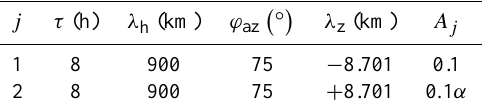
Table 1a. Properties of the AGWs to be superposed to generate the perturbation velocities. Note: The negative sign of λ z means downward phase propagation.